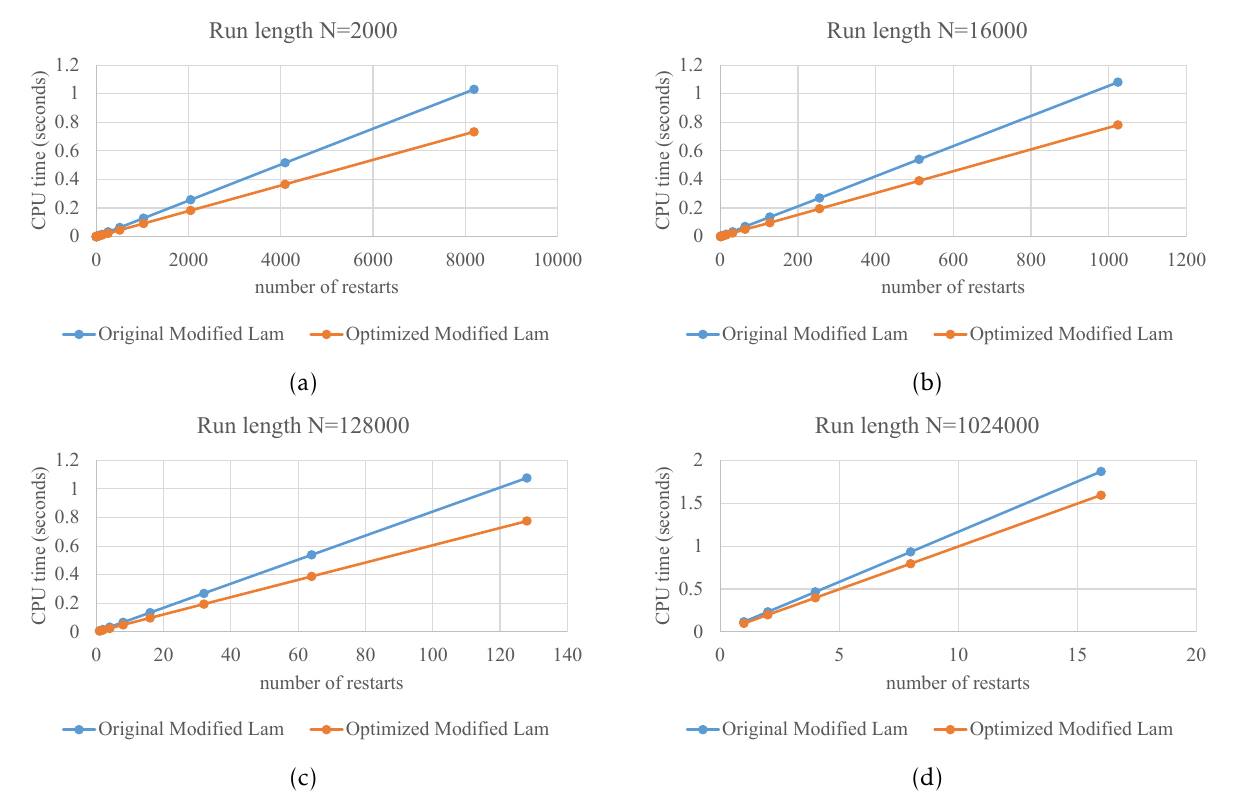
Figure 1. Runtime comparison of the original and optimized versions of the Modified Lam annealing schedule for runs of length: (a) 2000 iterations, (b) 16000 iterations, (c) 128000 iterations, and (d) 1024000 iterations. Each graph shows average CPU time in seconds as a function of number of